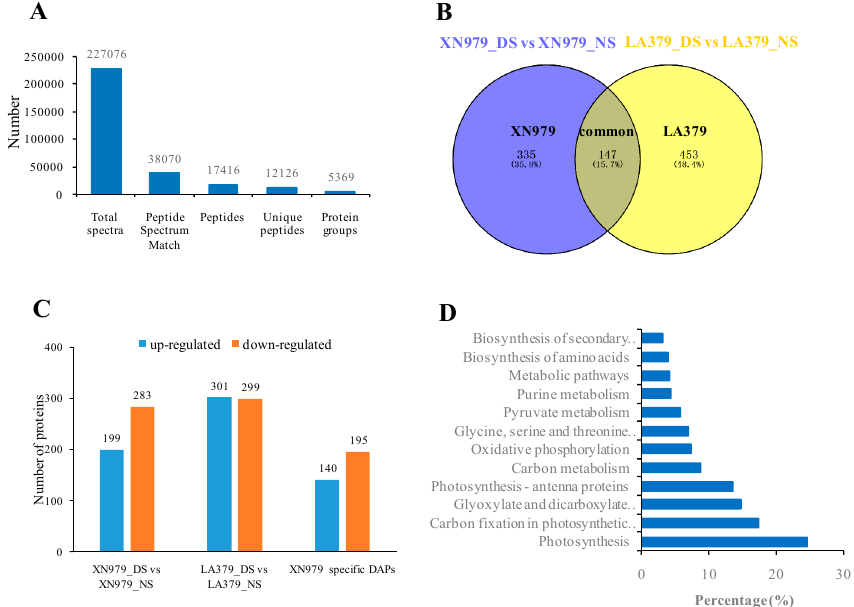
Figure 2. Statistical analysis of the proteome results and differentially abundant proteins (DAPs) under drought stress (DS) and control (NS) conditions. ( A ) Statistics for total spectra, matched spectra, matched peptides, unique peptides, and identified proteins. ( B ) Venn diagram analysis of DAPs in the one-to-one comparisons between NS and DS. ( C ) Number of up- and down-regulated DAPs in the XN979_DS-XN979_NS comparison, LA379_DS-LA379_NS, and drought-tolerant variety XN979 specific DAPs. ( D ) Enriched pathways of the DAPs specifically identified in XN979. The values on the abscissa indicate the percentage of the input number of DAPs among the number of the background proteins in the pathway; NS, no stress; DS, drought stress.